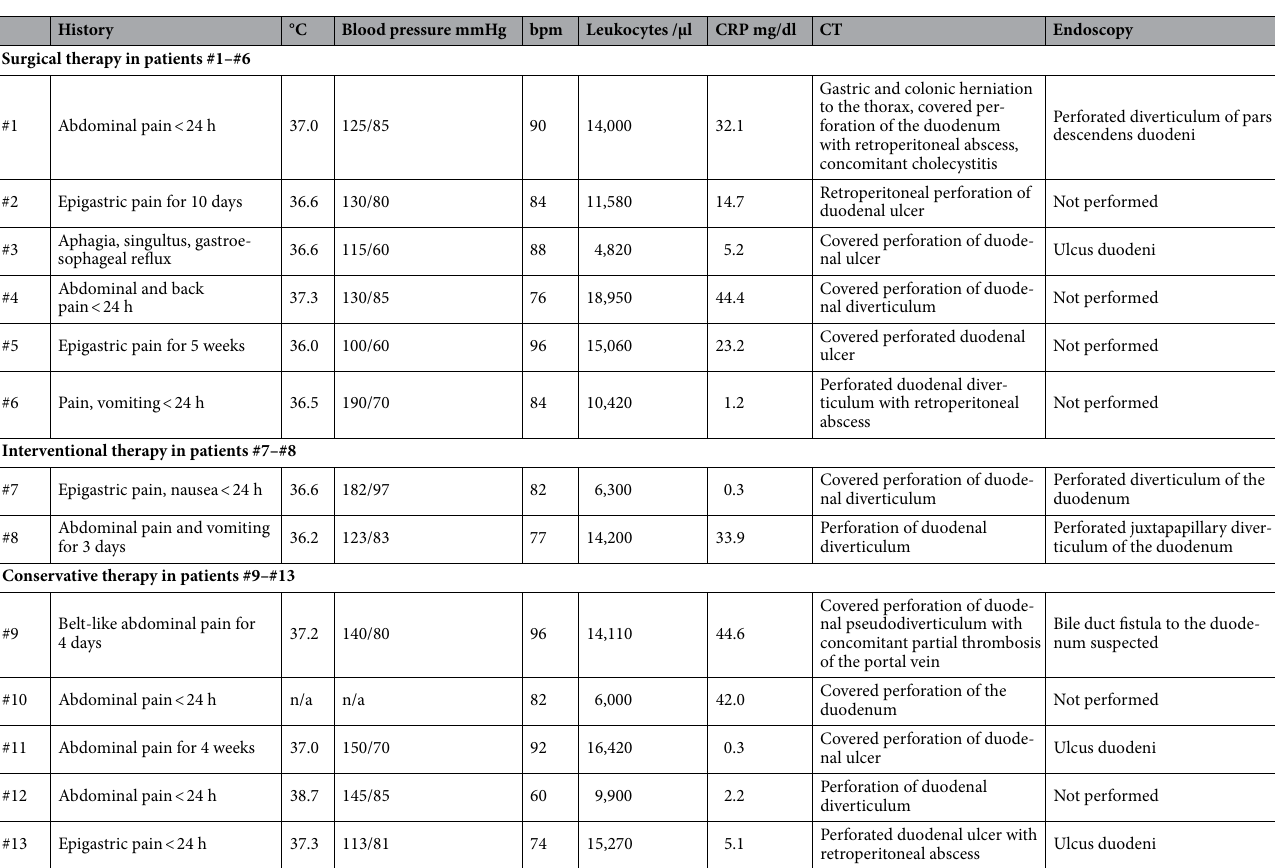
Table 2. Findings of physical examination, laboratory assessment, computed tomography and endoscopy at initial presentation. n/a: not available ; bpm: beats per minute , CRP: C-reactive protein, CT computed